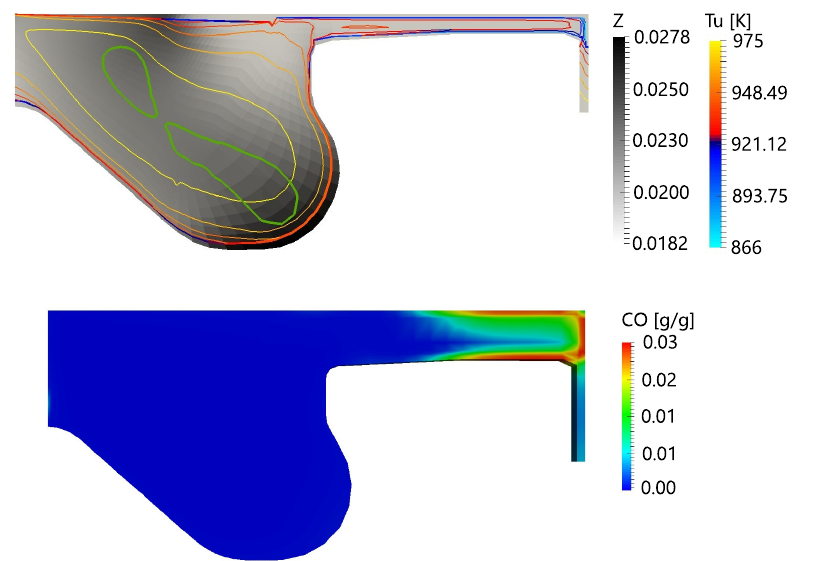
Figure 6. ( Top ): In-cylinder thermo-physical condition at the start of combustion (2.5 CAD), green contour represents the start of combustion. ( Bottom ) : CO distribution at the end of the combustion (16 CAD) for case b .